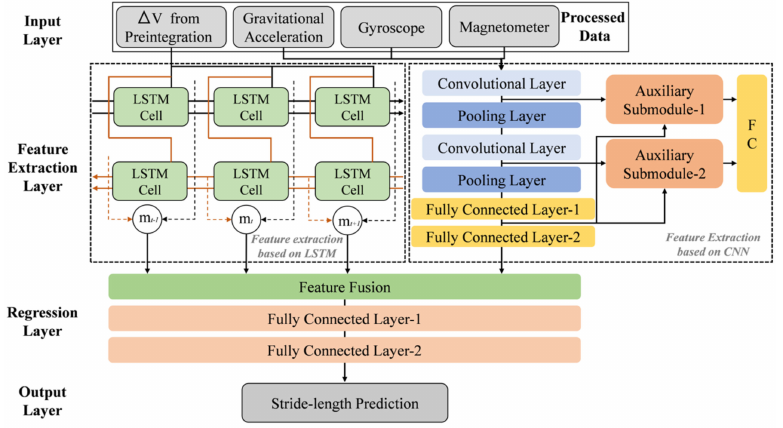
Figure 4. The efficient learning-based model architecture using spatial and temporal features repre- sentation for stride-length